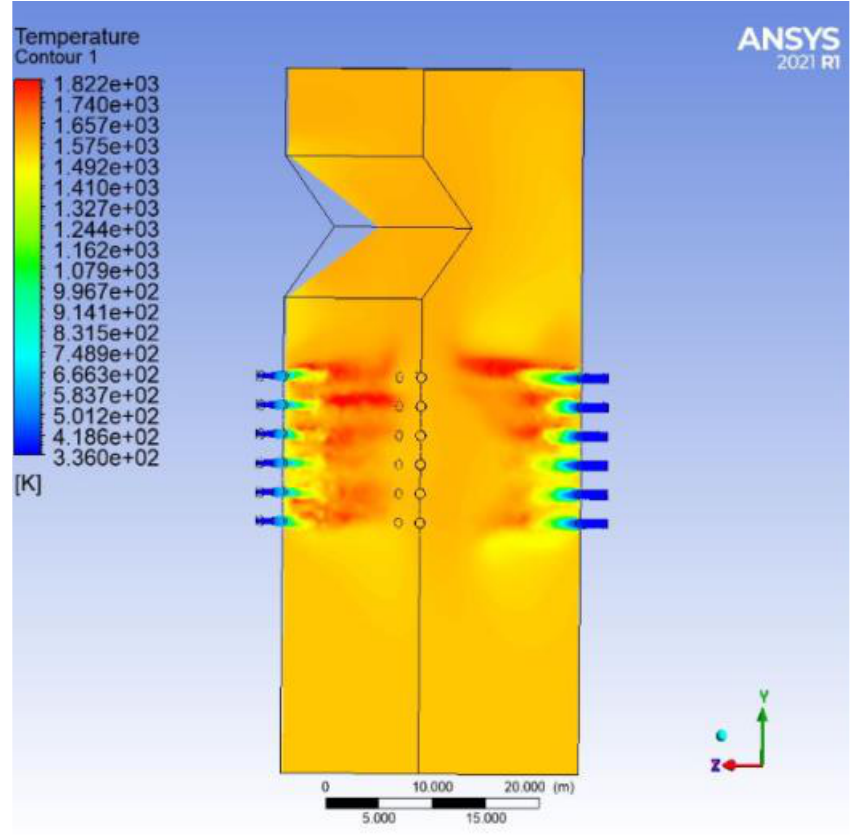
Figure 16. Temperature distribution of flue gas in case-VIII.